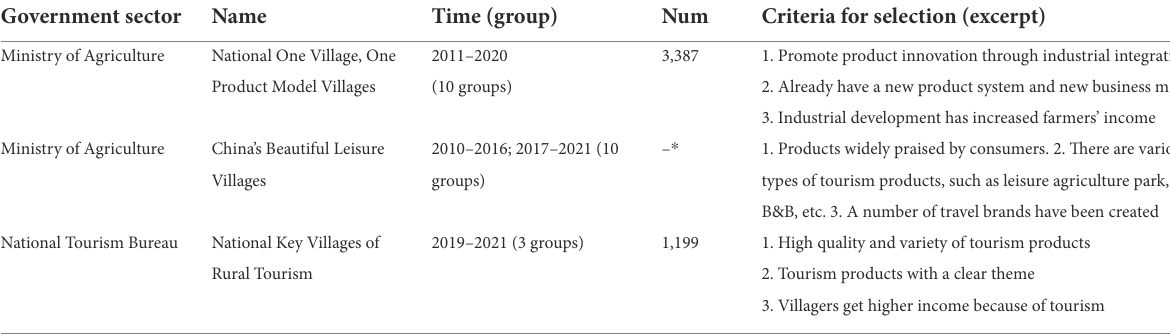
TABLE 2 Basic information and selection criteria for the three types of selected lists (excerpt).